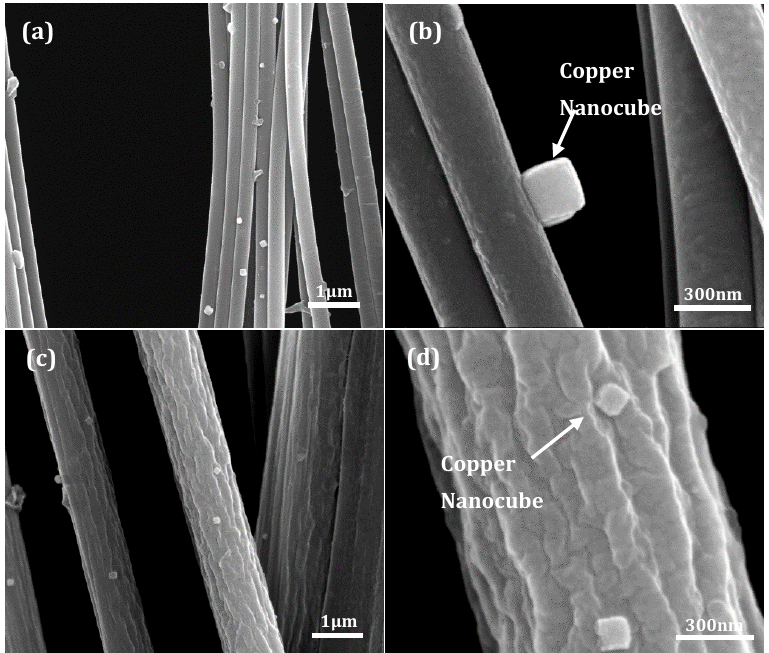
Figure 3. ( a ) Dispersed positions of nanocubes on nanofibers. ( b ) Higher magnification micrograph